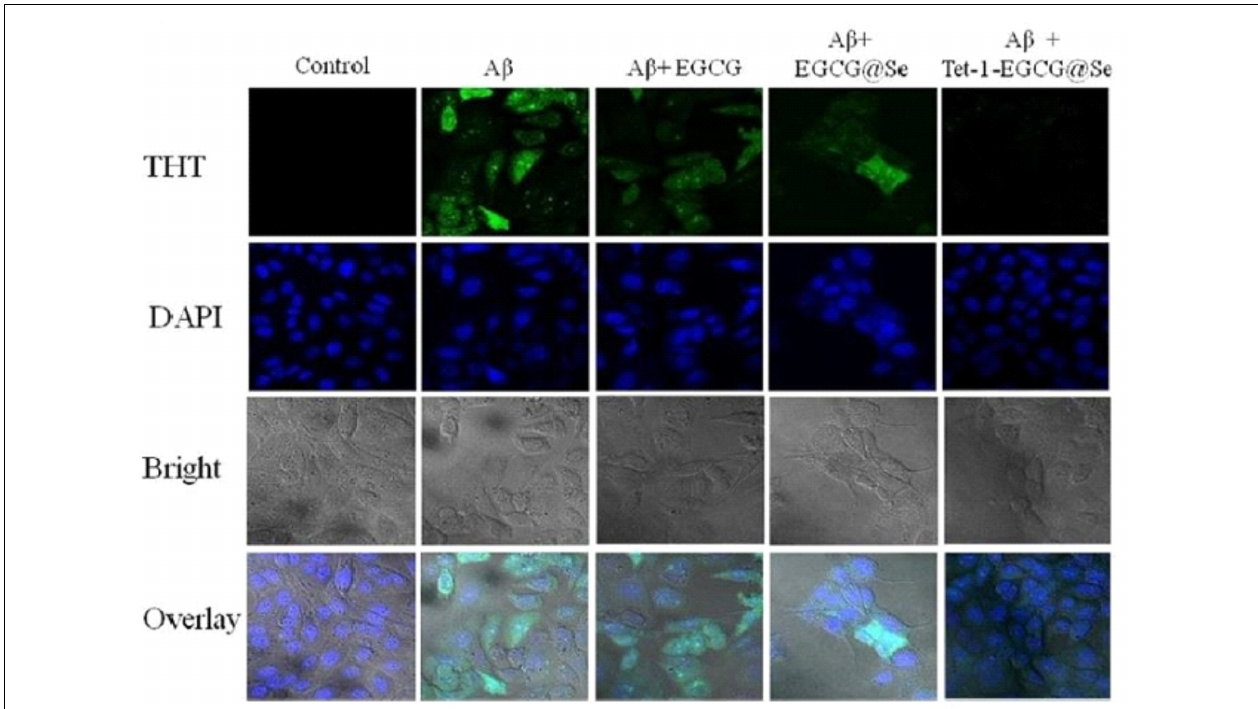
FIGURE 2 | Tet-1-EGCG@Se preventing A β aggregation in PC12 cells. The presence of intracellular A β fibrils was evaluated by ThT staining in PC12 cells in the absence and presence of EGCG, EGCG@Se, and Tet-1-EGCG@Se. The cells were pretreated with an A β monomer for 6 h to allow access of A β to the cytoplasm, sequentially incubated with EGCG, EGCG@Se, or Tet-1-EGCG@Se for an additional 48 h, and visualized under a fluorescence microscope (adopted with permission from Zhang J. et al., 2014).